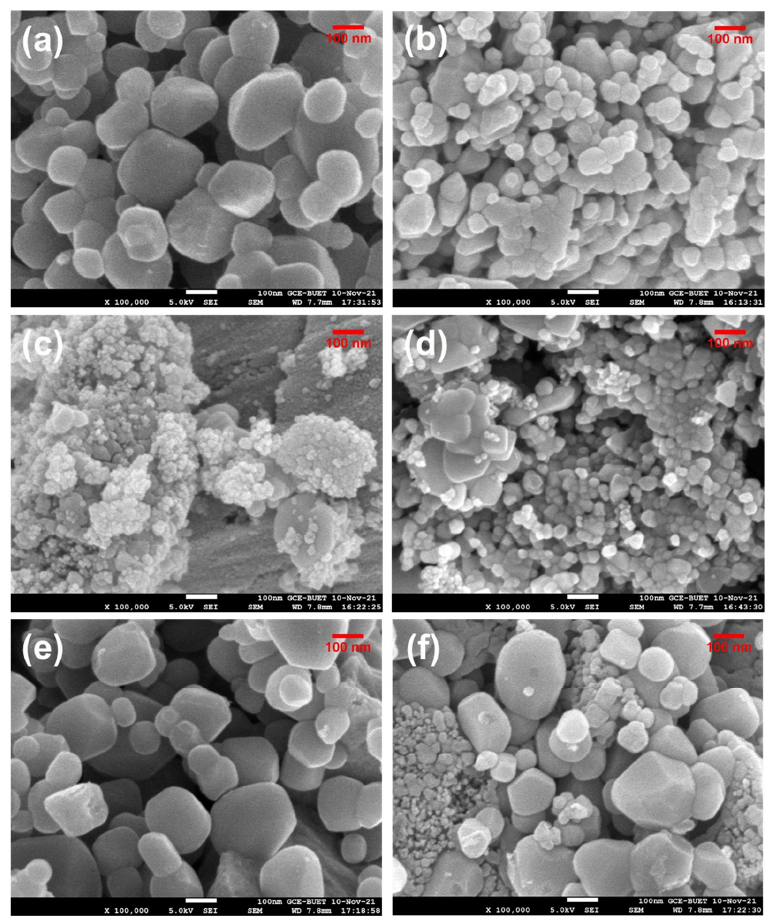
Figure 2. FESEM images of ( a ) TiO 2 , ( b ) ZnO, ( c ) B–ZnO, ( d ) ZnO/TiO 2 , and ( e , f ) B–ZnO/TiO 2 . The calculations for average particle size of nanocomposites were carried out through ImageJ software. The nanoparticles were marked at 59 different locations for TiO 2 , 132 for ZnO, and 61 for B–ZnO/TiO 2 using Figure 2a, 2b, and 2e, respectively, and plotted as a size distribution histogram (Figure S1a–c). The average particle size of nanocomposites is calculated to be 114, 53, and 88 nm for TiO 2 , ZnO, and B–ZnO/TiO 2 respectively. The average particle size measured by FESEM shows a good agreement with the XRD. 2.3. SEM and EDS Mapping Study SEM and EDS mapping examinations were carried out on synthesized B–ZnO/TiO 2 nanocomposite to determine the presence of boron (B) atom in the sample (Figure S2). From Figure S2b–e, it was observed that the various elements of B, Zn, Ti, and O were distributed throughout the sample, confirming the presence of all elements and the suc- cessful synthesis of B–ZnO/TiO 2 nanocomposites.